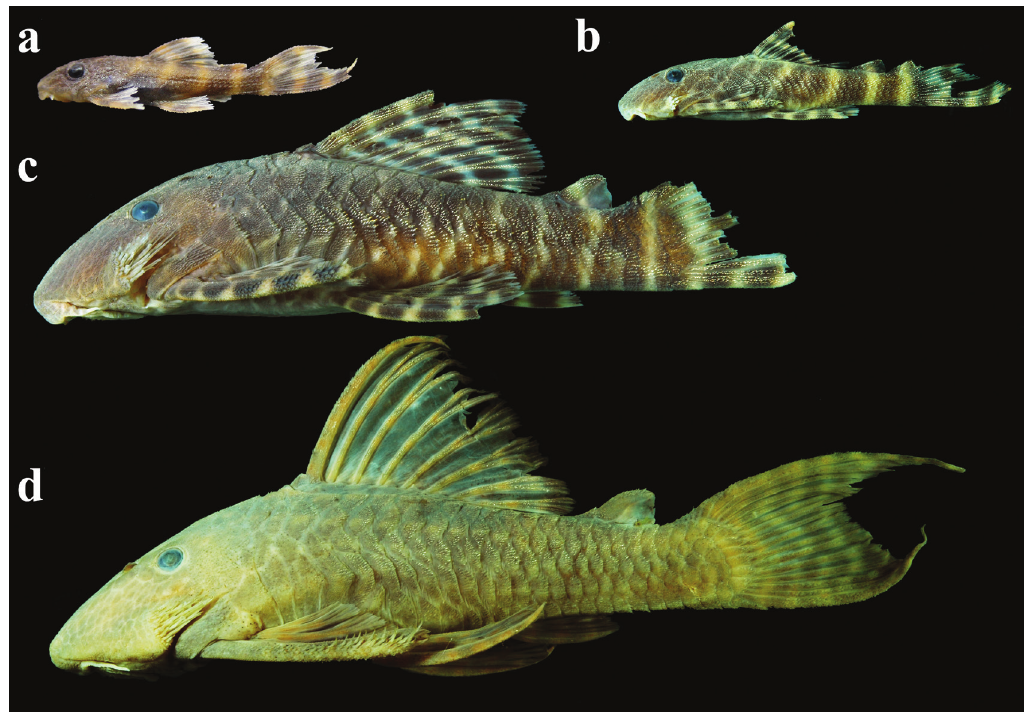
Fig. 4. Lateral views of recently collected Panaqolus purusiensis to show the different size-dependent color patterns: a) 15.5 mm SL; b) 42.8 mm SL; c) 83.3 mm SL (all UFRO-I 17720); d) 130.4 mm SL (MUSM 39425). Photos by B. S. F.